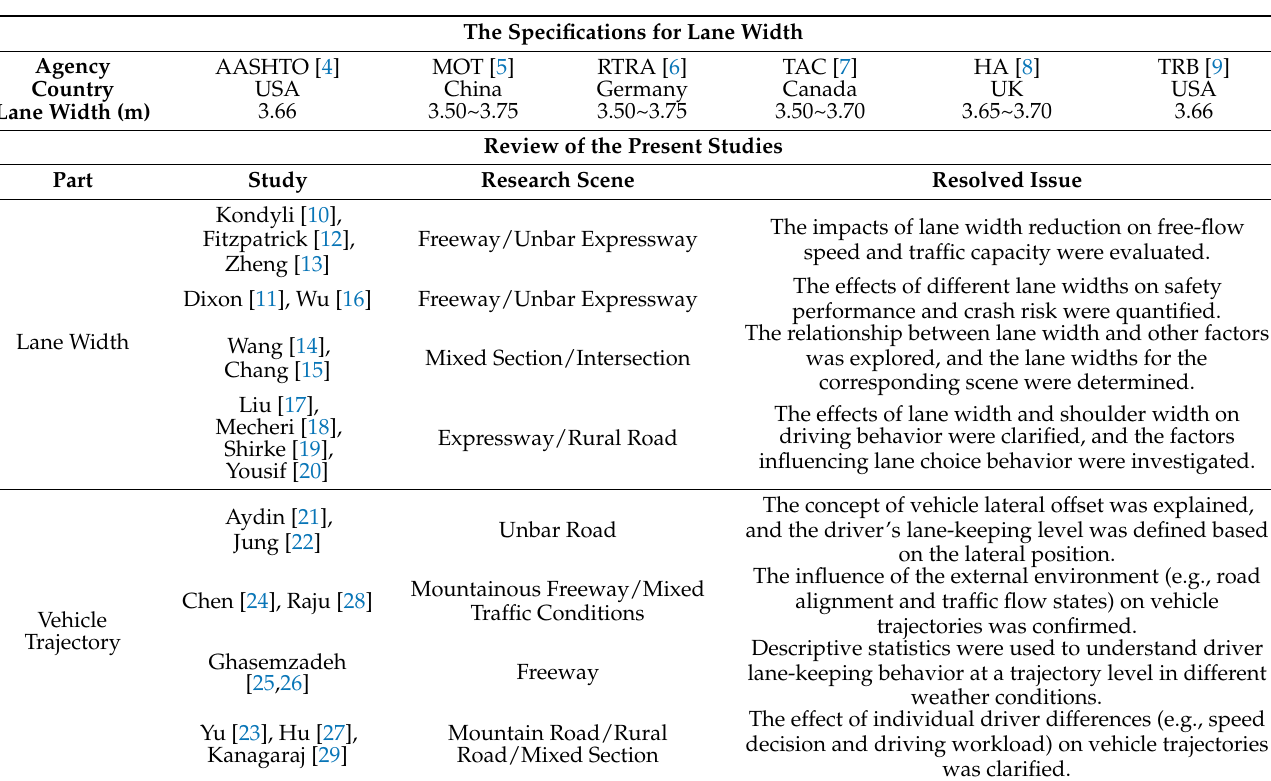
Table 1. Comparison of specifications for lane width and review of the present